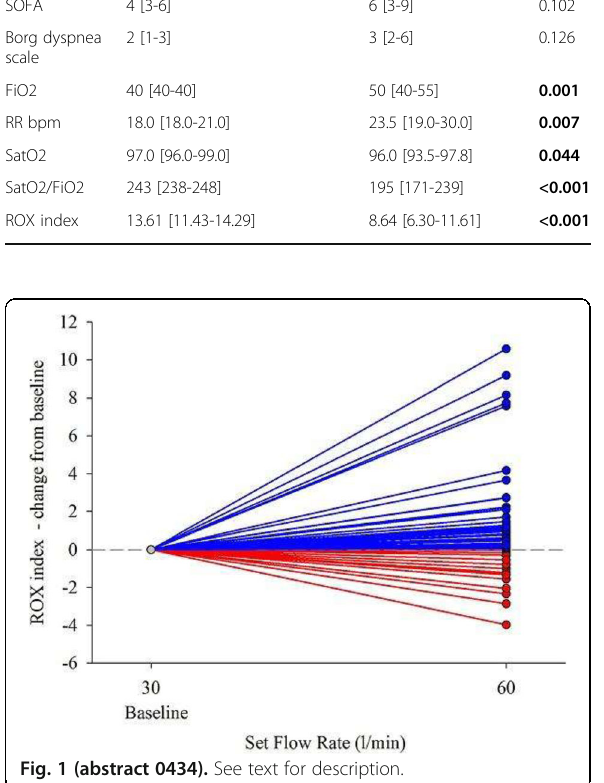
Fig. 1 (abstract 0434). See text for